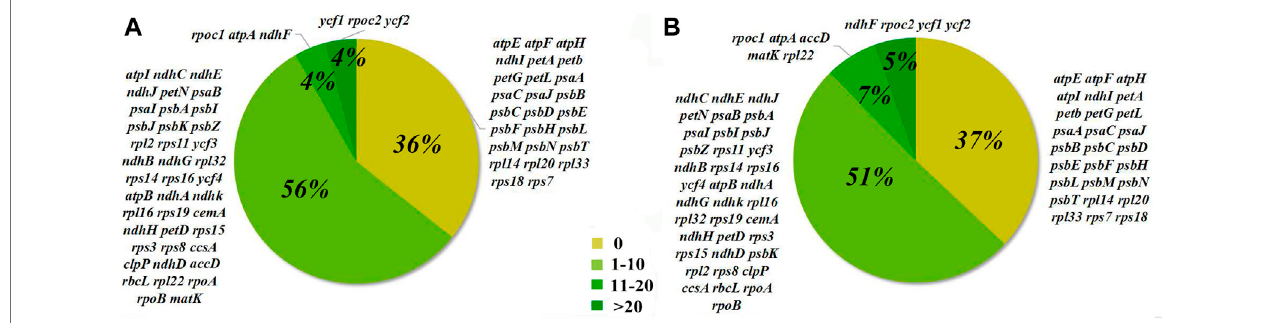
FIGURE3| Percentagesofthenumberofsitesselectedfrom73codinggenesin48 Acer species.A,analysisresultsofModelM2.B,analysisresultsofModelM8.